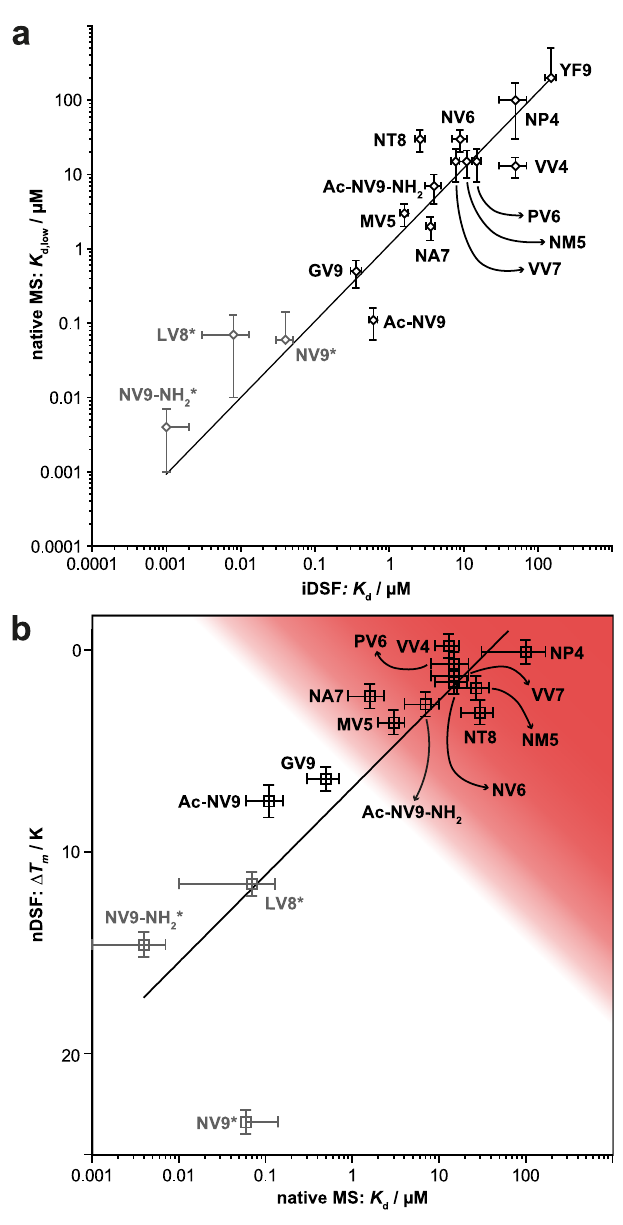
Fig. 4 Relation of thermal stability and af fi nity for dsA2/peptide complexes. a Af fi nities determined via iDSF and native MS correlate. Displayed data points represent the relationship of both apparent K d for all different dsA2/peptide systems analyzed. Both axes are scaled logarithmically. b Thermal denaturation measurements availing intrinsic tryptophans ’ change in fl uorescence are used to de fi ne protein complex stabilization upon peptide binding, whereas an apparent K d for the various peptides is determined using native MS (10 V acceleration voltage and 150 V cone voltage). The dsA2 complex and peptide are deployed in a ratio of 1:10 ( Δ T m ) or 1:5 ( K d ) depending on the experiment. Peptides showing a small K d,low for binding dsA2 and being concomitantly able to stabilize the protein complex are de fi ned as strong binders (white area). The remaining peptides (red area) lack crucial features, making them unable to form strong bonds to dsA2 indicated by low binding af fi nities and melting temperatures. The standard deviation for both methods is displayed by error bars. The x coordinate is displayed logarithmically. *iDSF reaches its limits at af fi nities below 200 nm, hence the values of grayed-out peptides are not